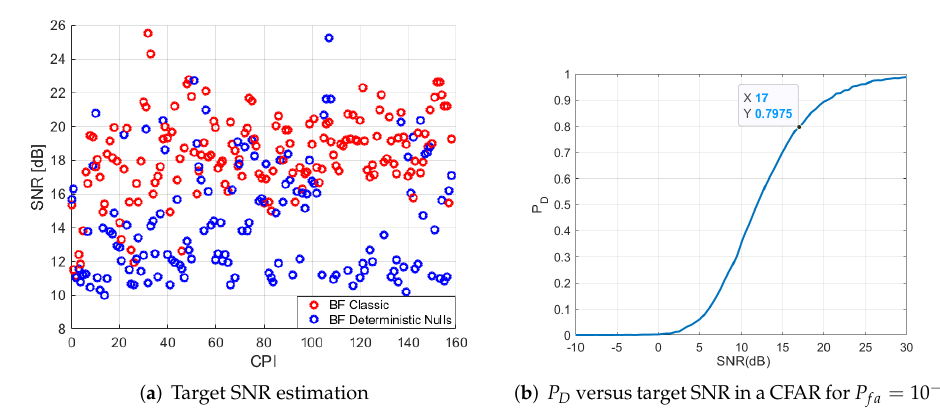
Figure 11. ( a ) SNR of selected targets in each CPI for classical beamforming and deterministic nulls generation; ( b ) curve of required SNR for a given P D and P fa = 10 − 5 in case of a CFAR considering Swerling I